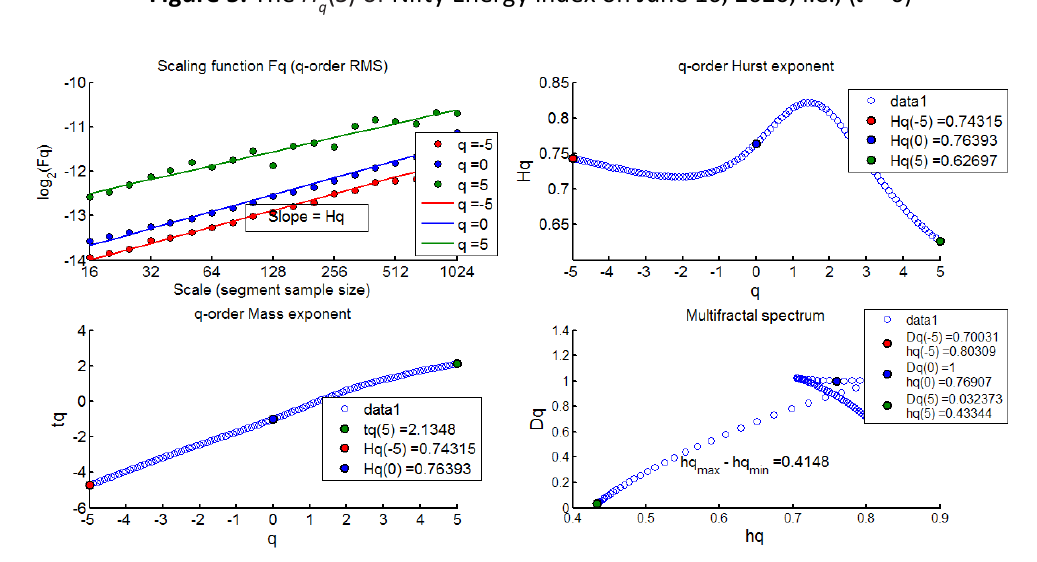
(5) of Nifty Energy index on June 17, 2020, i.e., ( t = +1) Figure 6. The H q